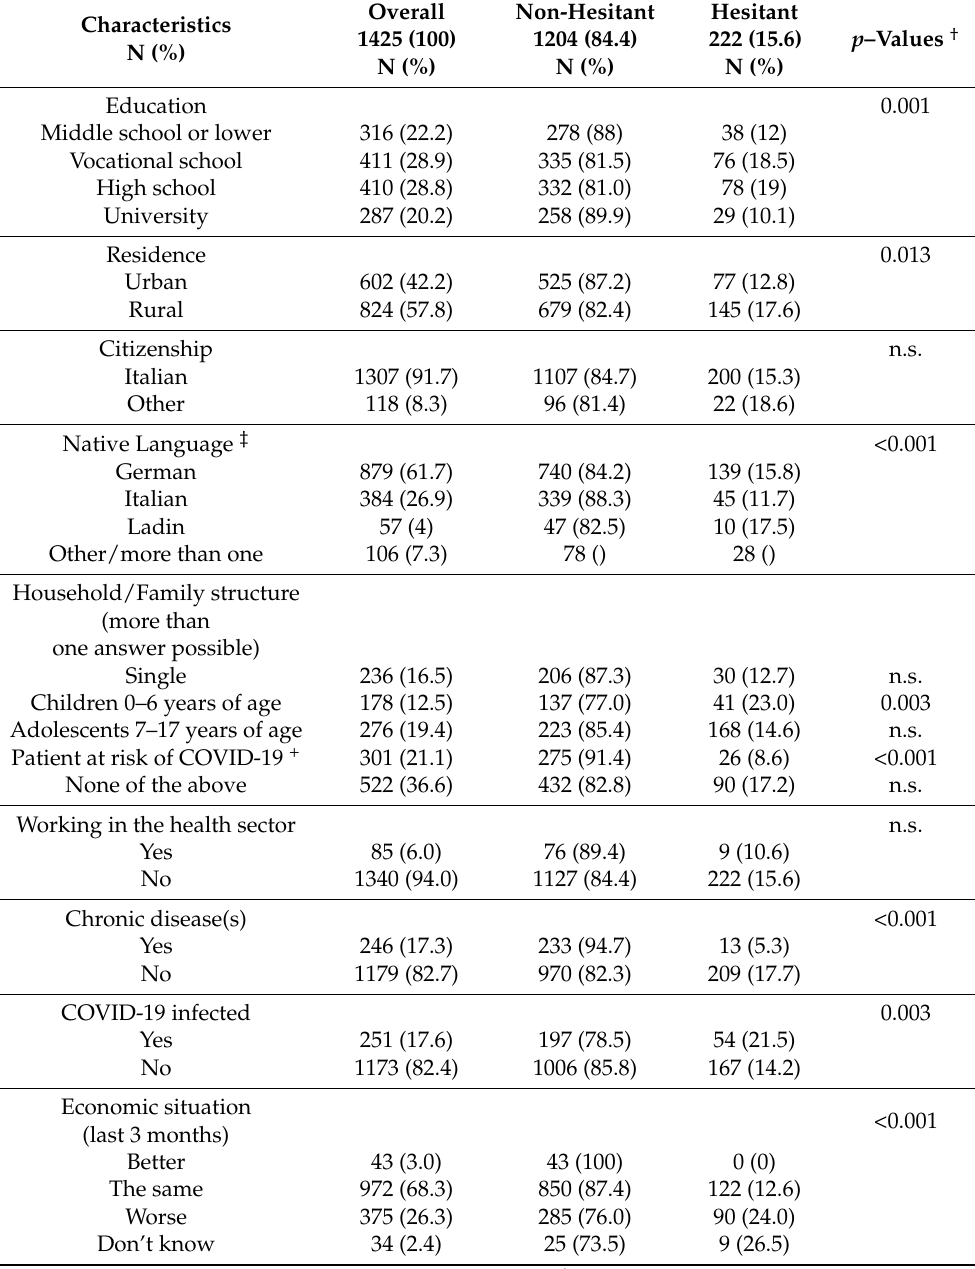
† p -values refer to chi-square tests for non-hesitant vs. hesitant. ‡ Mother tongue of South Tyrolean inhabitants. + Participants living together with a patient at risk of COVID-19 in the same household. In our survey in March 2021, approximately 15% of the participants were in the hesi- tancy group. (Figure 1). The percentage of people who were either vaccine non-hesitant or who had re- covered from SARS-CoV-2 infection corresponded well with vaccine uptake until 6 Septem- ber 2021